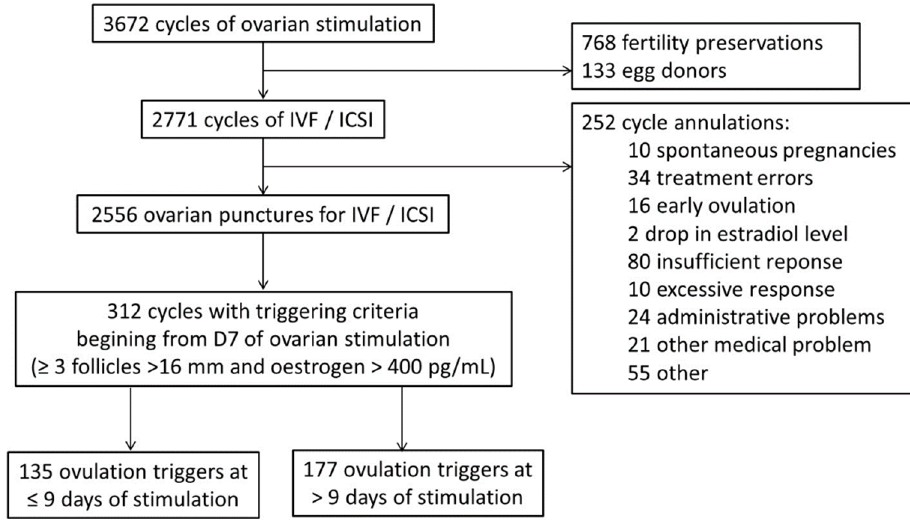
Figure 1. Flow chart.